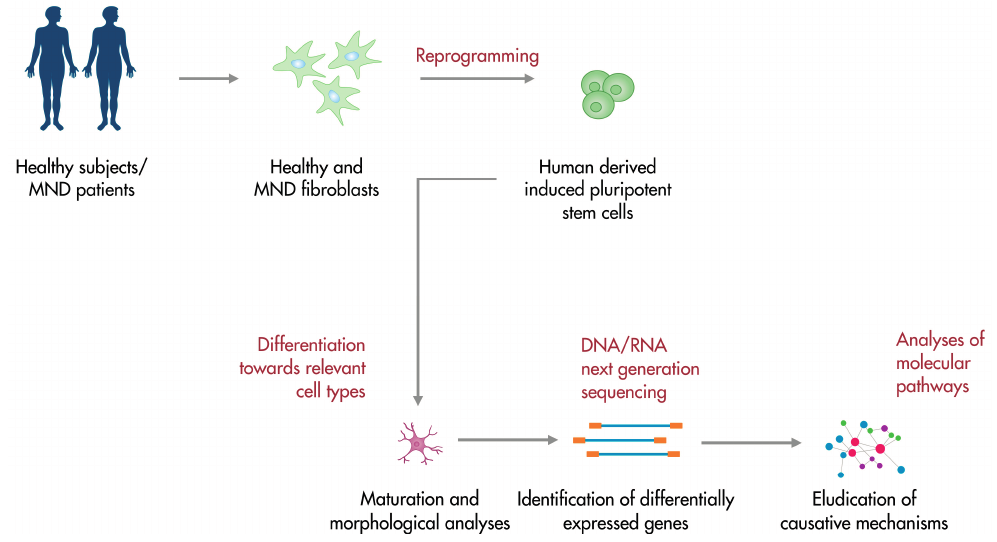
Figure 1. iPSC-based platforms for motor neuron disease modeling. Patients-derived somatic cells can be reprogrammed into iPSCs. Obtained cells can be differentiated towards the subtype of interest and studied in their development. Further analyses include the investigation of the transcriptional profile and the elucidation of molecular pathogenetic pathways. Human iPSCs are also a valuable tool for the identification of molecular targets and the screening of potential therapeutic